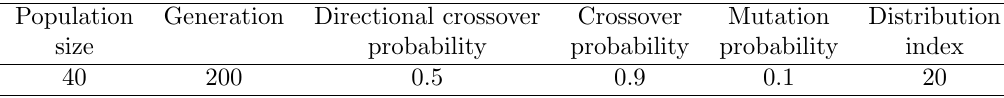
Table 2: Algorithm parameters of the implemented NSGA-II